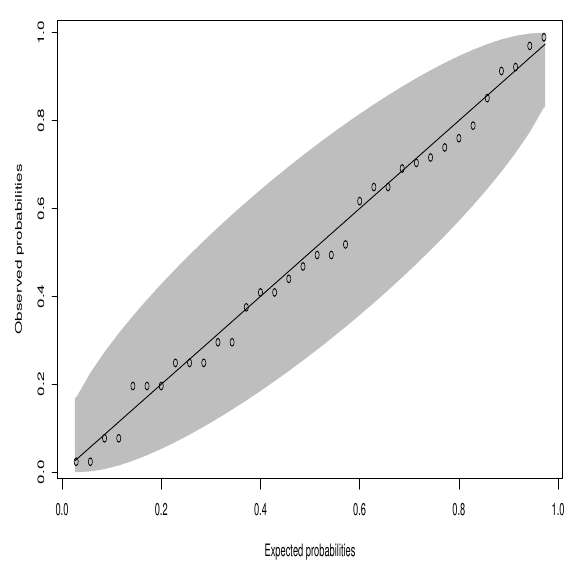
Figure 5. PP plot of the survival data set.